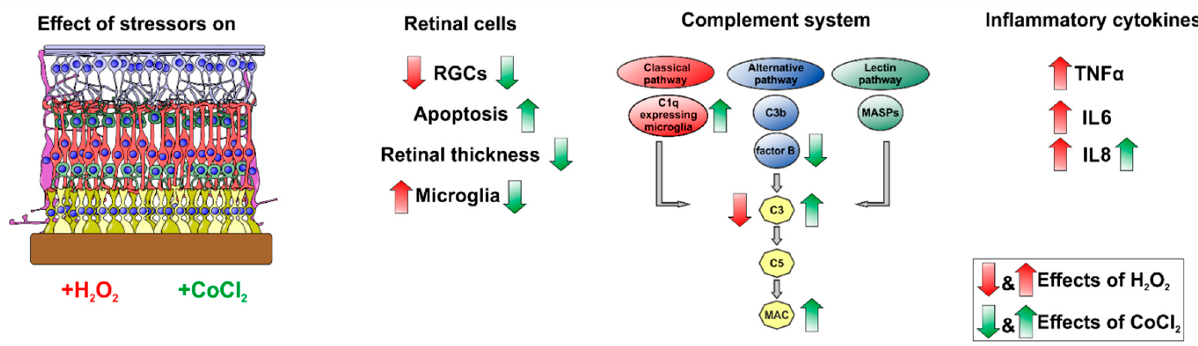
Figure 10. Graphical summary of the study. Porcine retinas were cultivated for two and four days. The role of the complement system was evaluated after the induction of oxidative stress or hypoxia. Both stressors, H 2 O 2 (shown with red arrows) and CoCl 2 (shown with green arrows) had strong degenerating effects on retinal ganglion cells (RGCs). Hypoxic retinas, stressed with CoCl 2 , had more apoptotic RGCs and had a significantly decreased thickness of the whole retina as well as of the ganglion cell complex. Different effects of H 2 O 2 and CoCl 2 on microglia were noted: H 2 O 2 -stressed retinas led to more microglia whereas CoCl 2 was toxic to microglia. The complement system played no prominent role in oxidative stressed retinas, but there was a strong activation of the complement system occurring via the classical pathway in hypoxic retinas. Furthermore, we noted a strong increase of inflammatory cytokines mostly in H 2 O 2 -stressed retinas.